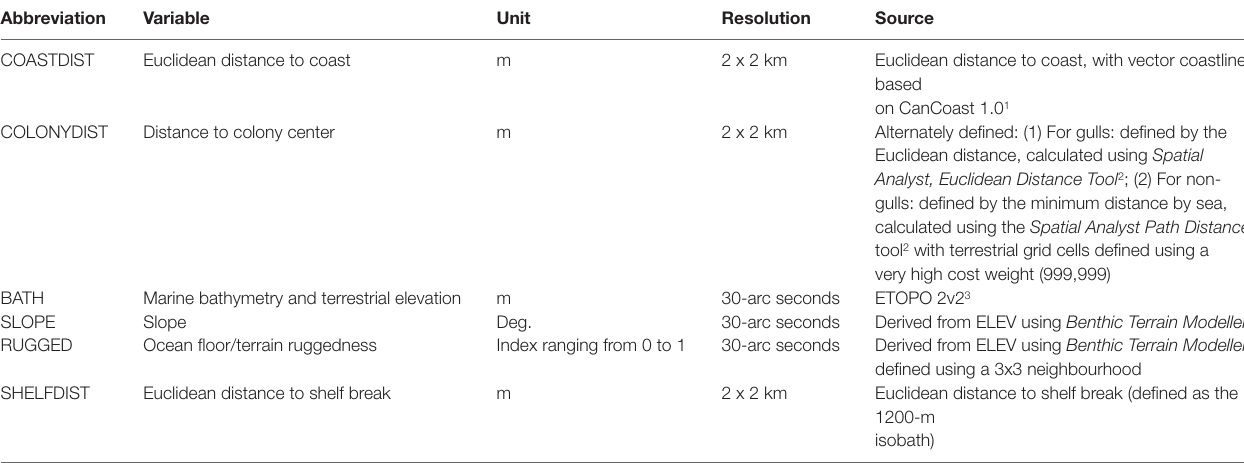
TABLE 3 | Environmental predictor variables used to construct colony-centered species distribution models.